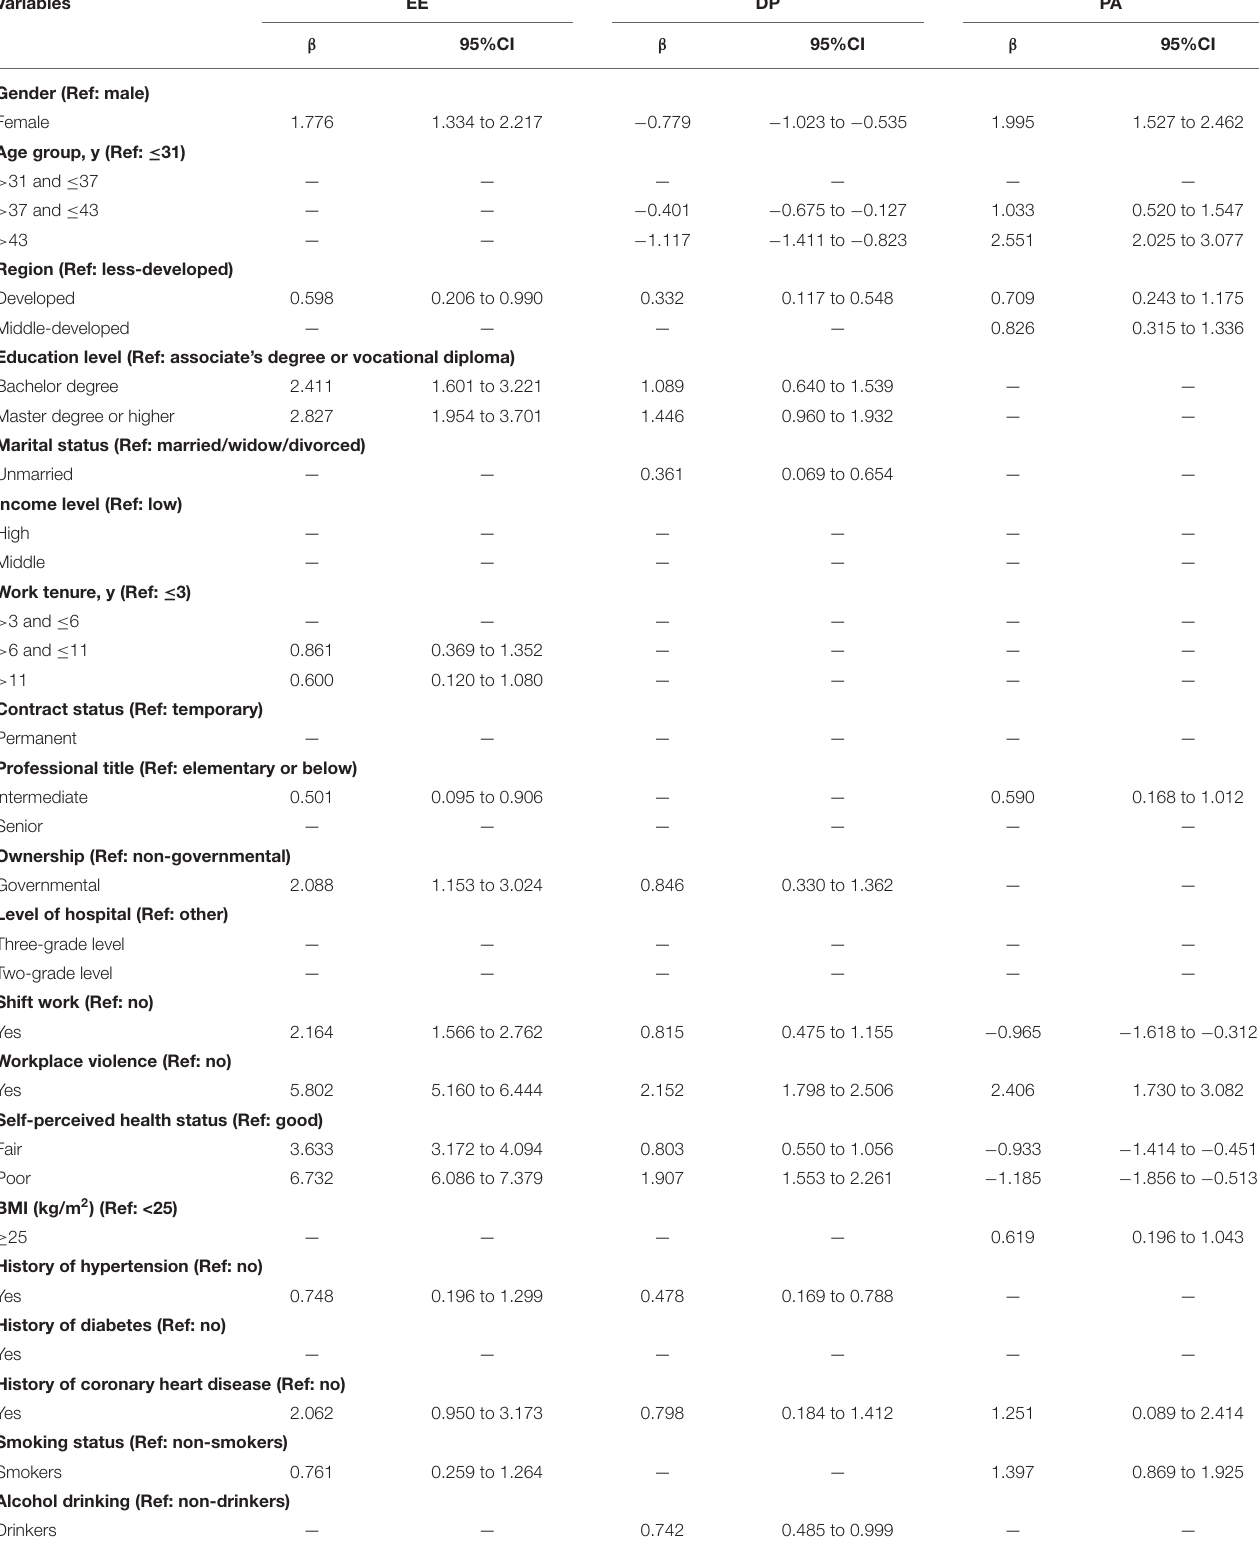
TABLE 3 | Correlates of burnout in emergency physicians: results of stepwise regression.